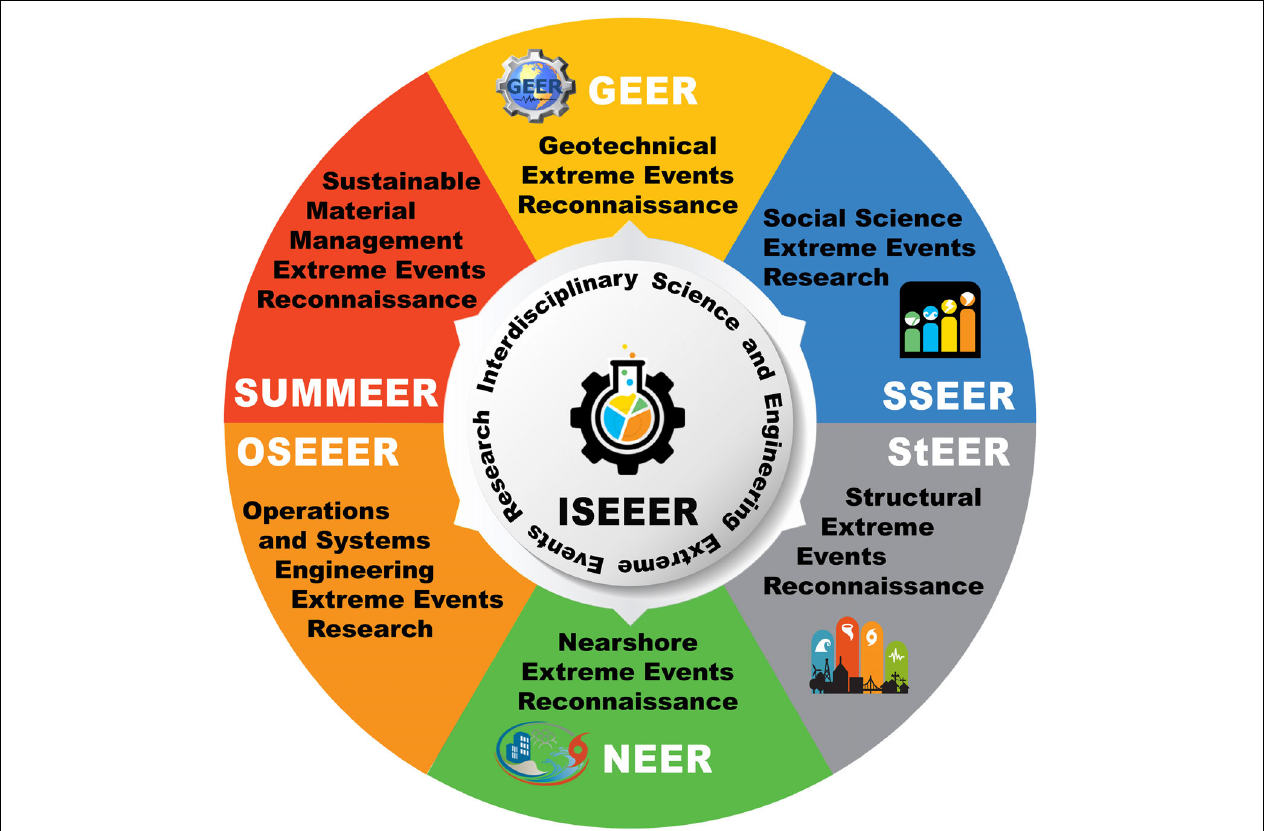
FIGURE 5 | NSF-supported extreme events reconnaissance and research